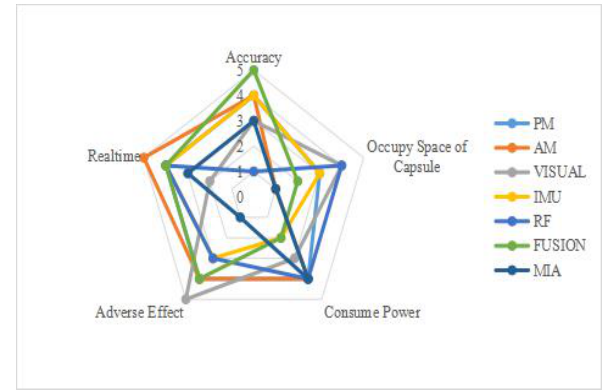
Figure 4. Radar diagram of performance comparison